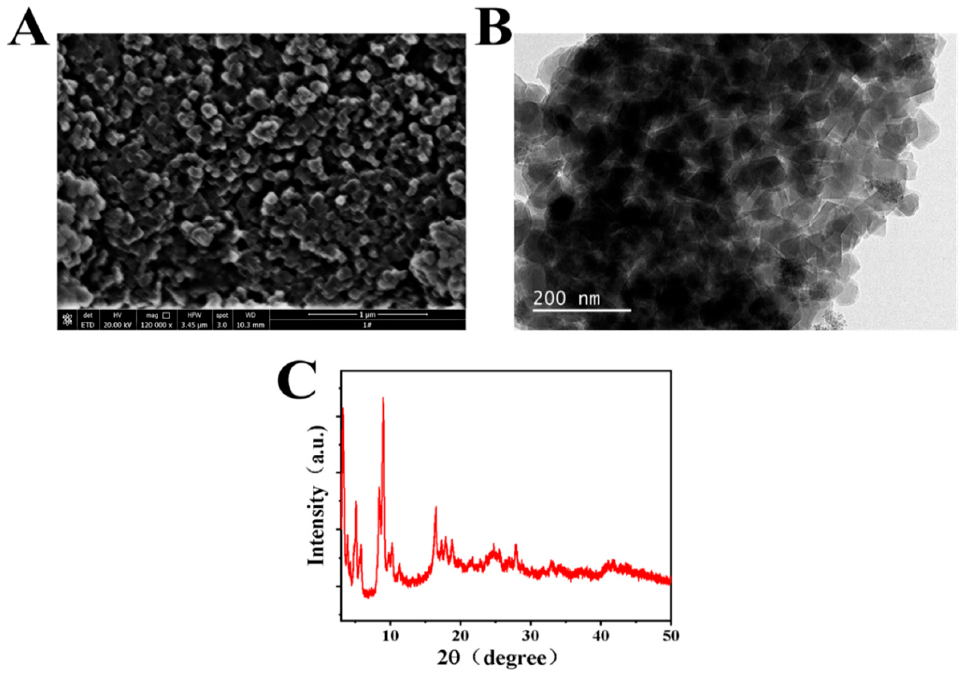
Figure 1. ( A ) SEM, ( B ) TEM, and ( C ) XRD of the prepared Cr-MOF sample. Cyclic voltammetry (CV) technology is commonly applied to investigate the elec- trochemical properties of modified electrodes. Figure 2A compares the CV curves of bare GCE and Cr-MOF-modified GCE (Cr-MOF/GCE) in the solution containing 2 mM